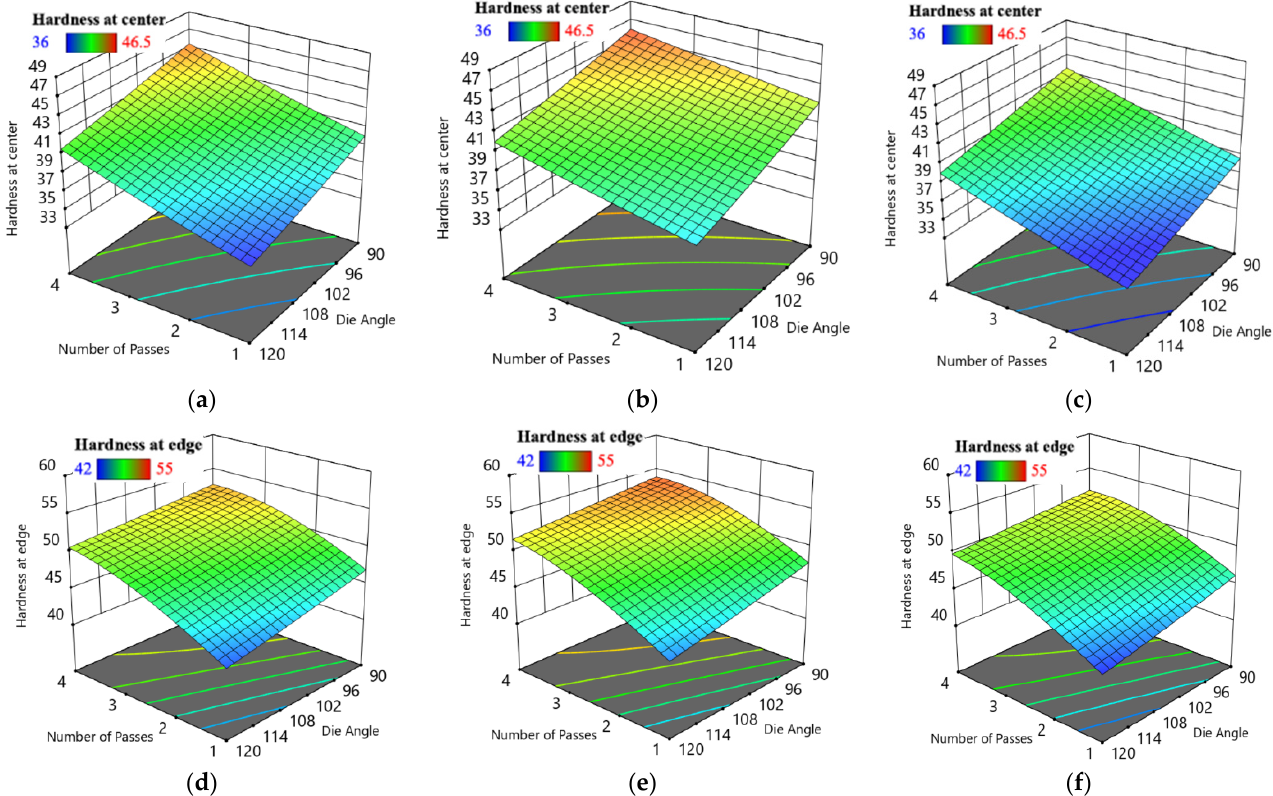
Figure 8. Three-dimensional plot of H C ( a – c ) and H E ( d – f ) with N and ϕ at route A ( a , d ), Bc ( b , e ) and C ( d , f ).